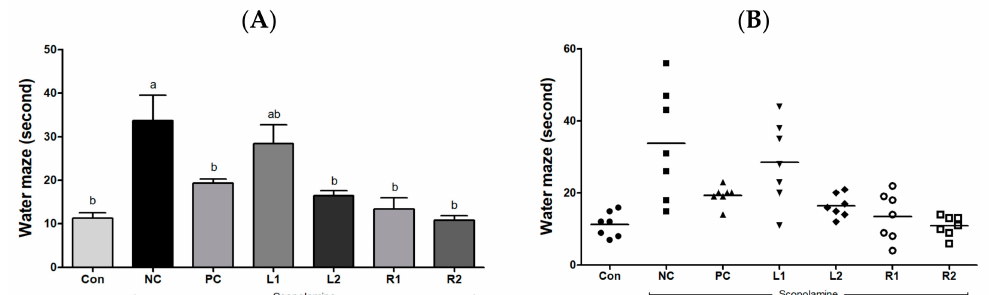
Figure 2. Effects of Allium hookeri leaf and root extracts on the water escape time of C57BL/6 mice with memory impairment induced by scopolamine. ( A ) Arrival time at the escape zone of the group; ( B ) individual arrival time at the escape zone. All values are expressed as the mean ± SEM ( n = 7). a,b Differences were considered statistically significant at p < 0.05.